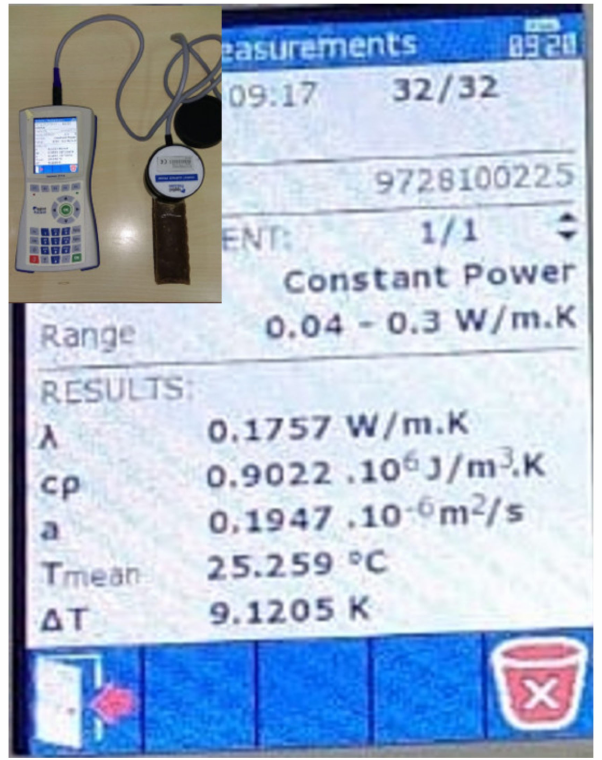
Figure 2. Isomet 2114 Portable Heat Transfer Analyzer next to results obtained from the Arbofill sample (screen capture) [55].